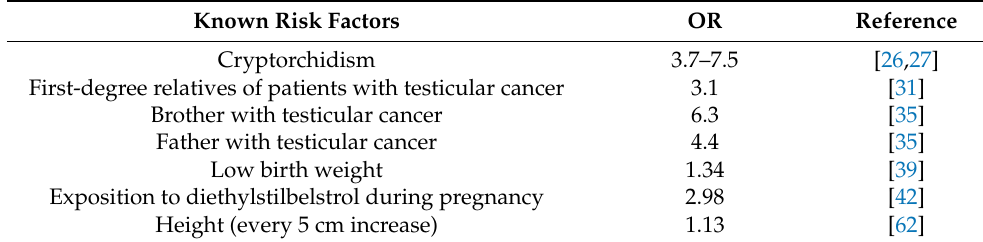
Table 1. Known risk factors associated with testicular cancer.